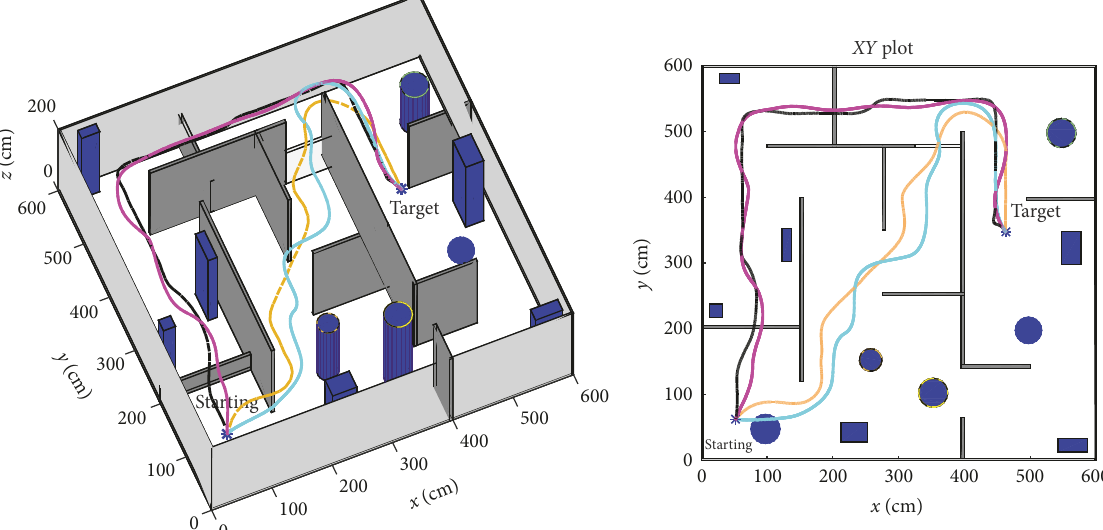
Figure 6: Comparison between the proposed approach based on different UAV sizes (20 cm (cyan line), 40cm (magenta line)) and the A-star applied on the occupancy grid taking into account different UAV sizes (20cm (orange line), 40 cm (black line)).